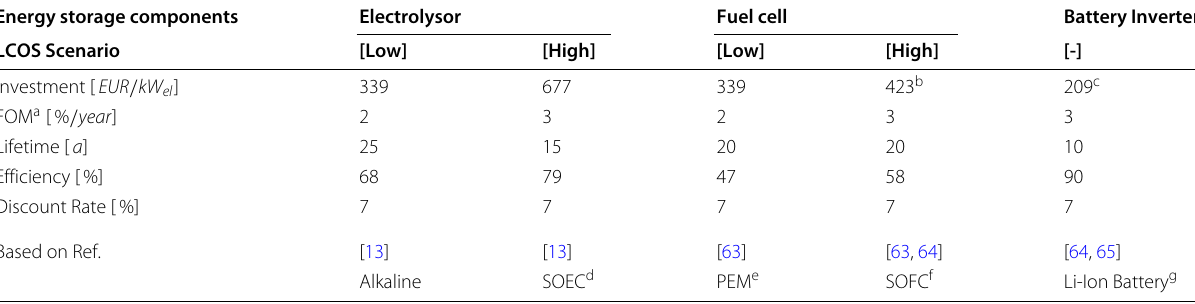
Table 1 Power related energy storage model inputs representing 2030 data Energy storage